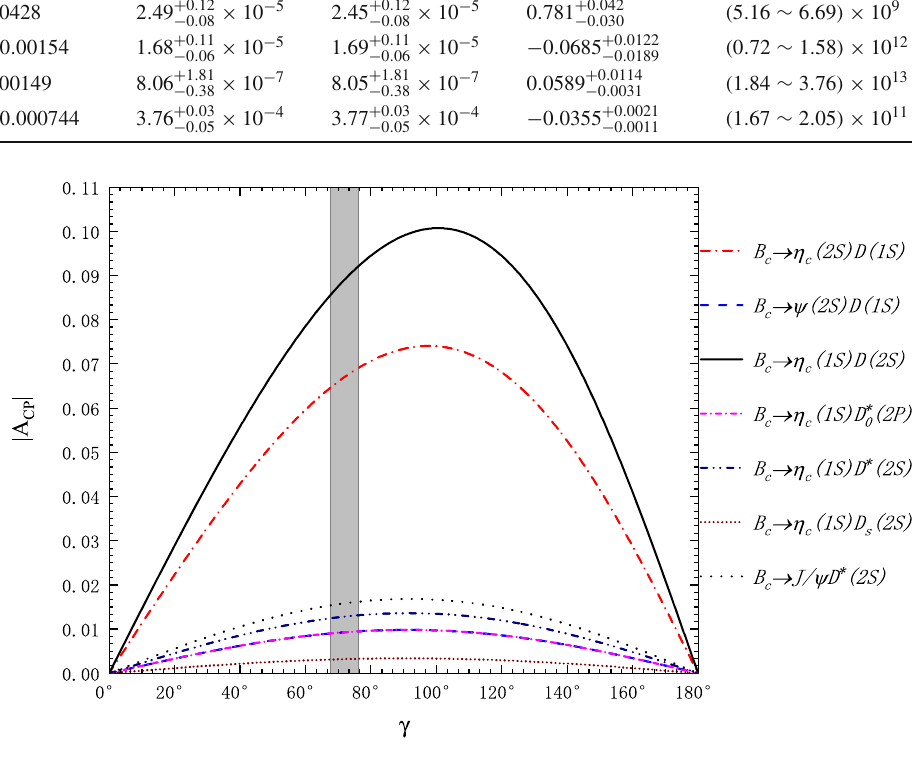
Fig. 2 The dependence of | A | on the weak phase γ . CP The gray band is the constrained range of γ measured in B decay, which is about 67 . 6 ◦ ∼ 76 . 2